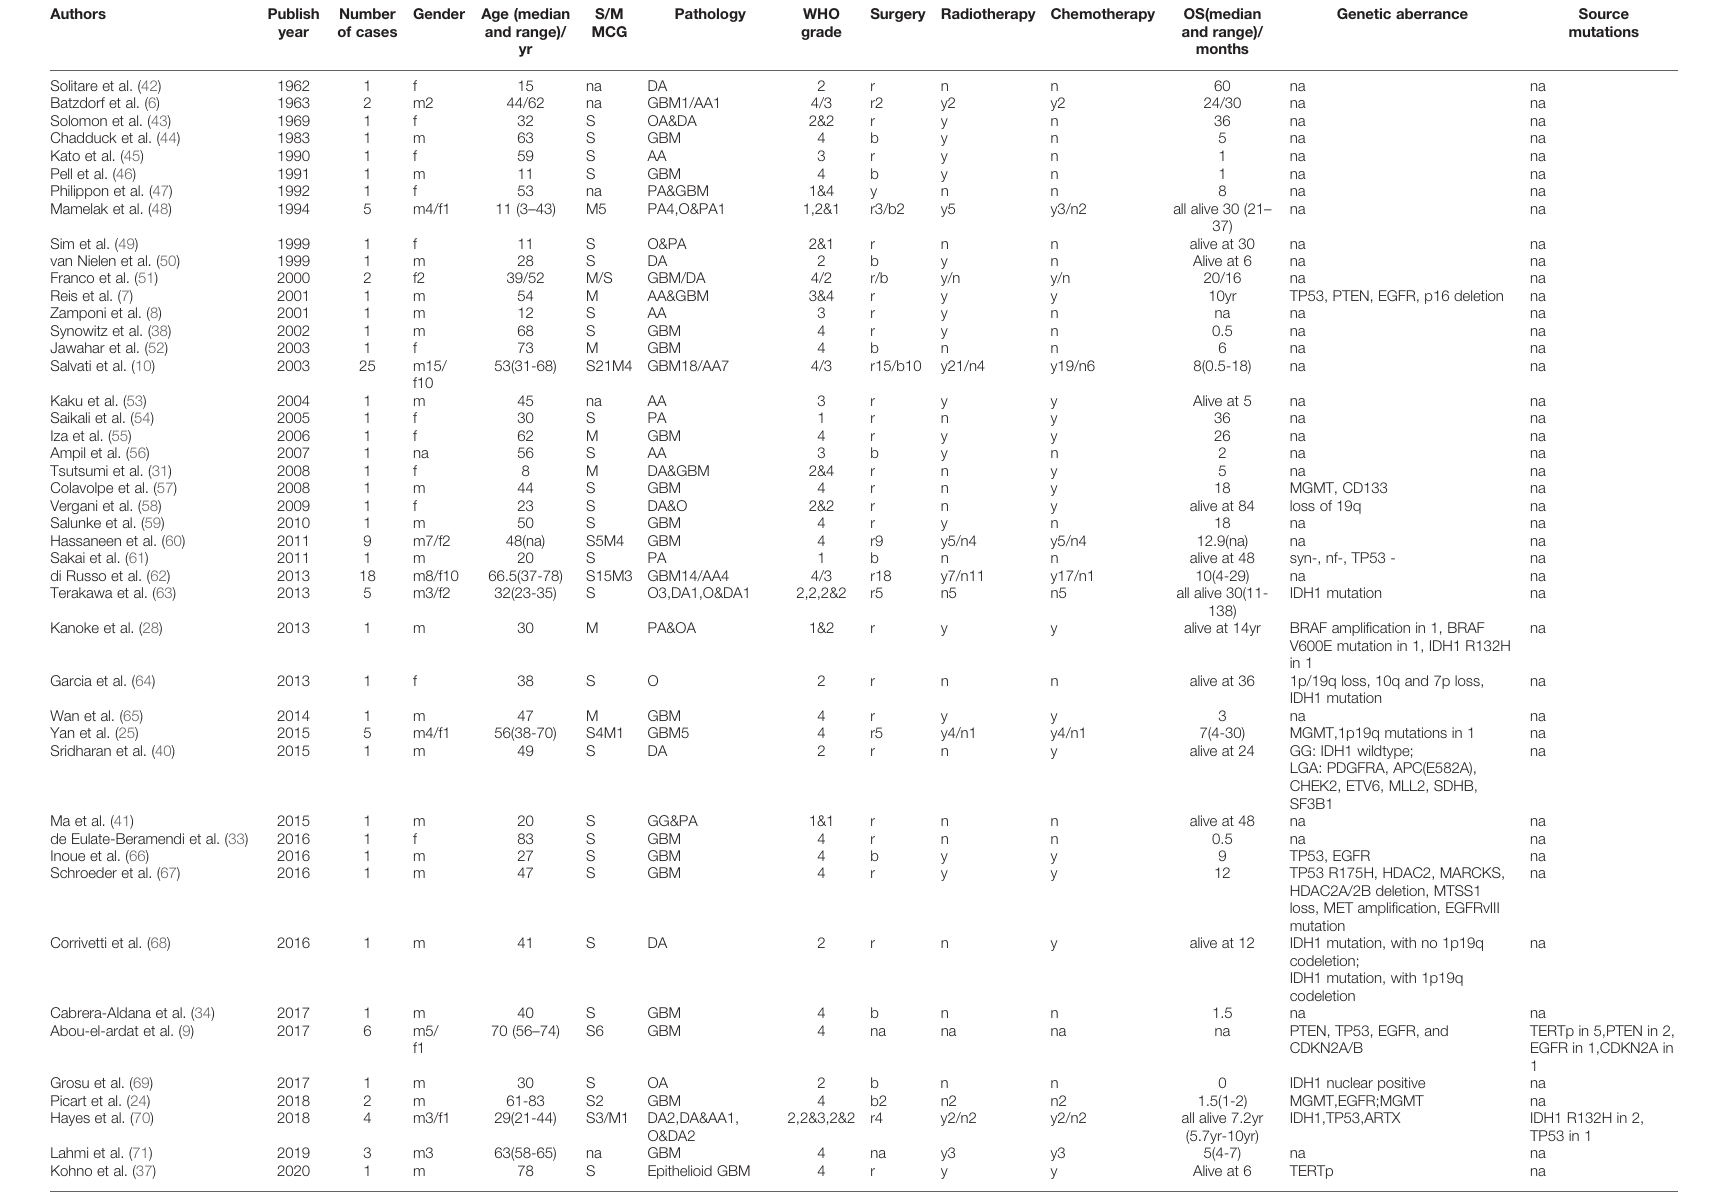
Surgery Radiotherapy Chemotherapy OS(median